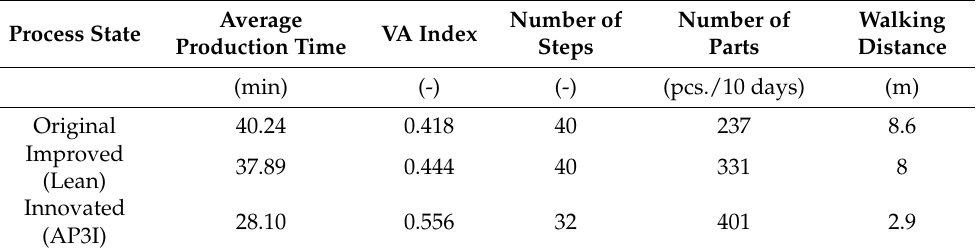
Table 10. Comparison of improvement by classical indicators—assembly line.